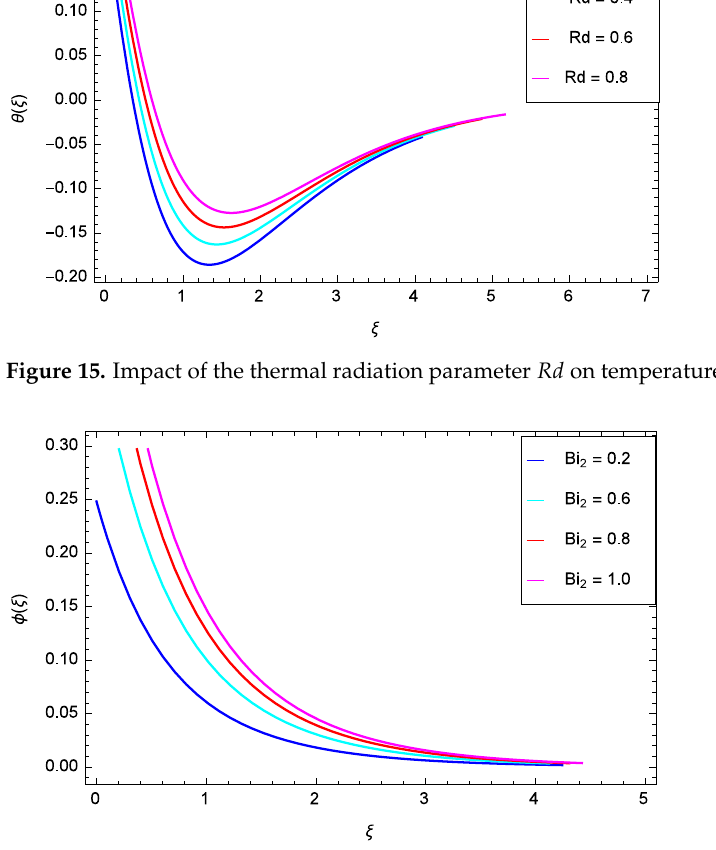
Figure 16. Impact of the solutal Biot number Bi 2 on concentration φ ( ζ ) .